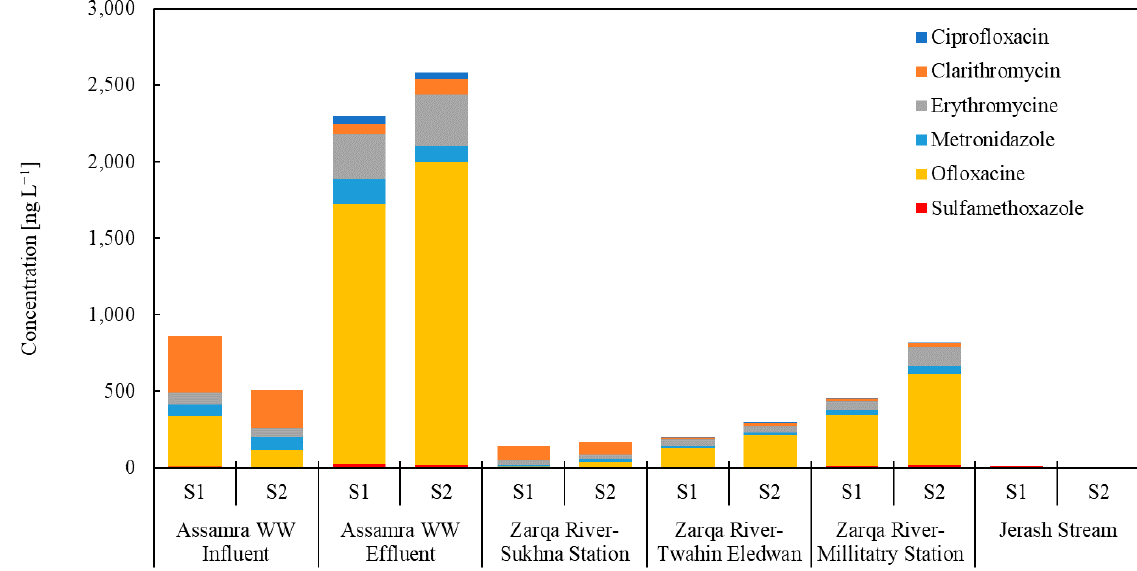
Figure 4. Concentrations of antibiotics (ng L − 1 ) in Assamra wastewater treatment plant (WWTP) influent ( n = 2) and effluent ( n = 2), and in water from the Zarqa River at Sukhna station, ( n = 2), Twahin Eledwan station ( n = 2), Military station ( n = 2), and Jerash stream ( n = 2). S1, S2 = parallel samples.